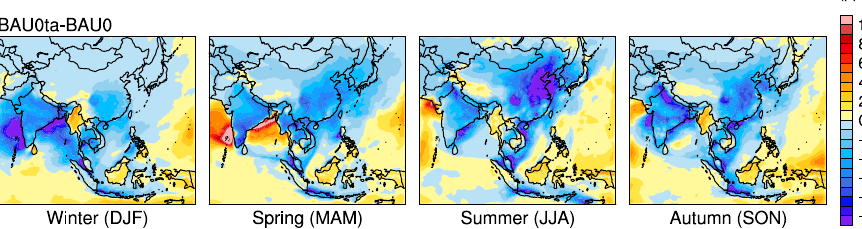
Figure 11. Horizontal distributions of differences in simulated seasonal mean surface ozone concentrations between BAU0ta and